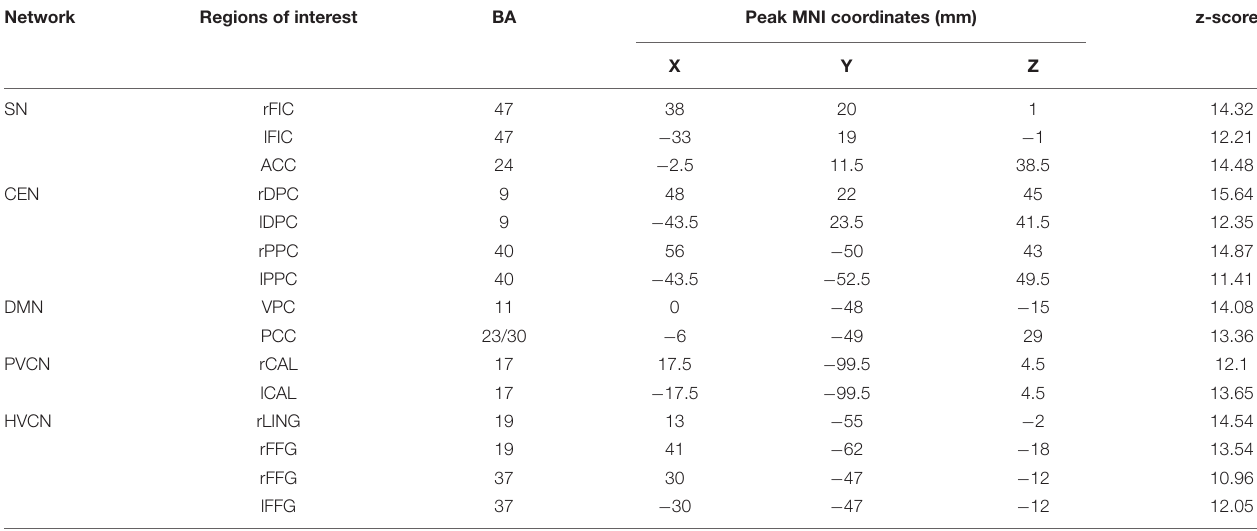
BA, Brodmann’s area; MNI, Montreal neurological institute; SN, salience network; CEN, cerebellum network; DMN, default mode network; PVCN, primary visual cortex network; HVCN, higher visual cortex network; rFIC, right frontoinsular cortex; lFIC, left frontoinsular cortex; ACC, anterior cingulate cortex; rDPC, right